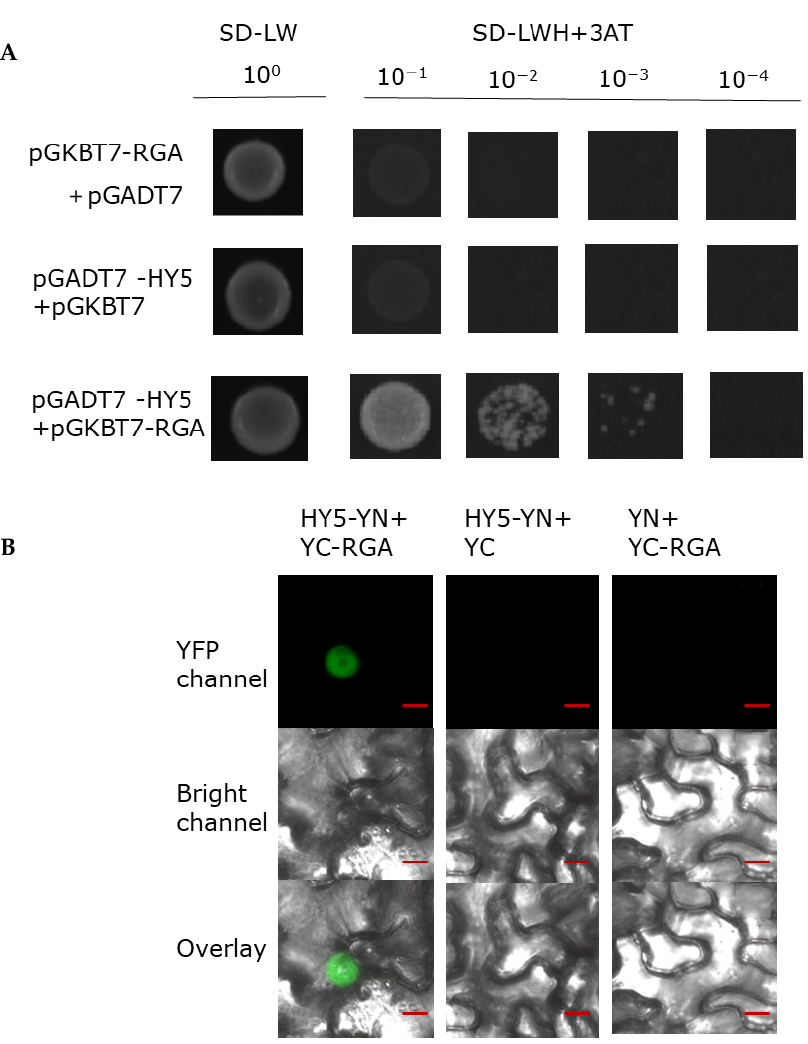
Figure 7. RGA physically interacts with HY5. ( A ) Yeast was transformed with a ‘bait and a prey’ construct. The bait vector constructs contain a GAL4-DNA binding domain fused with RGA, and the prey vector constructs contain the GAL4-activation domain fused with HY5 in the LexA system. Transformants were grown on SD/-Leu/-Trp/-Ade/-His (+X- α -gal) selective media. pGBKT7-RGA/pGADT7-HY5 was used as the positive control. ( B ) A BiFC assay was used to verify the interaction between RGA and HY5. Full-length HY5 and RGA were respectively fused to the split of the N- or C-terminal (YFP-N and YFP-C) fragments of YFP. Unfused YFP-N-terminal (YFP-N) and YFP-C-terminal (YFP-C) were used as negative controls. Overlay, overlay image included YFP channel and bright field channel. Scale bars: 10 μ m. Fluorescence signal was detected by confocal microscopy.